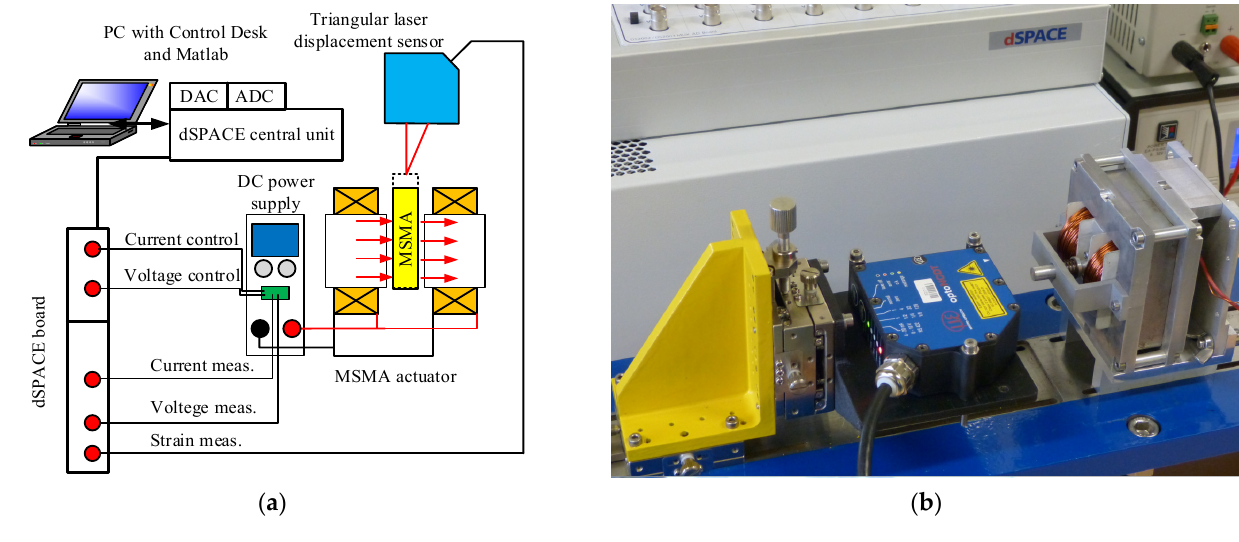
Figure 12. Test stand schematic diagram ( a ) and assembled set up ( b ).